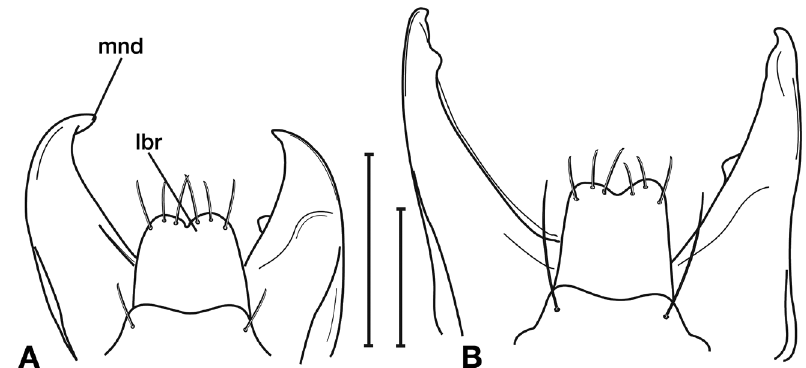
Figure 23. Line drawings comparing mandible form of A Catascopus ( s. str. ) asaharti sp. n. B Catascopus ( Catascopoides ) horni Jedlička . Legend: lbr labrum; mnd mandible. Scale bars: 0.5